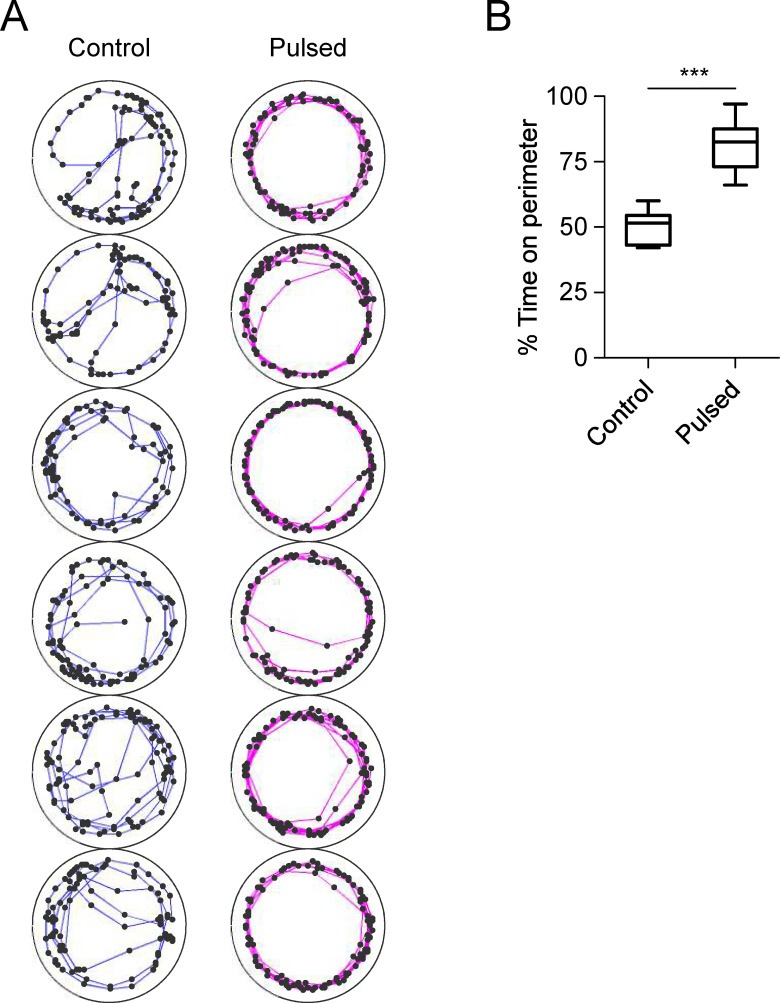
Increased boundary preference in w1118 male flies after pulsed light stimulation.(A) Locomotor trajectories in the circular arenas. Each circle represents the arena (1.27cm diameter). The dots are the fly positions (calculated centers of mass) and the connecting lines show the trajectories during 20 s of locomotion for control (blue lines) and pulsed flies (pink lines). (B) % TOP in control (n = 8) and pulsed (n = 8) w1118 flies. Asterisks (***) indicate P < 0.001 by Mann-Whitney test.